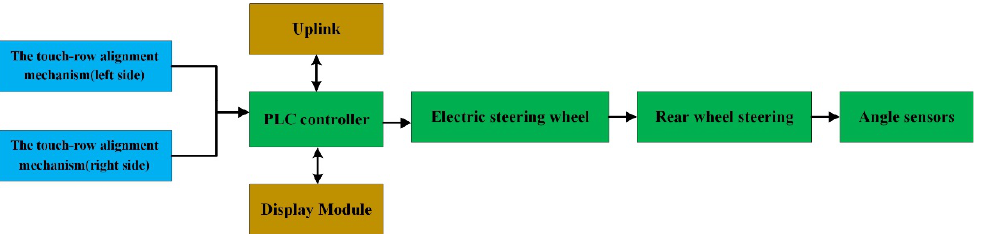
Figure 1. Automatic line control system structure diagram.